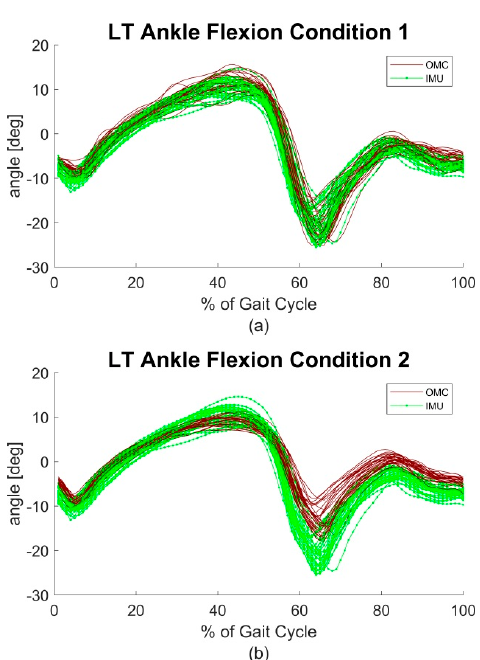
Figure 2. Left (LT) ankle flexion of a representative subject. Soft tissue artefacts (STA) error excluded ( a ) and included ( b ). At 60 to 100% Gait Cycle (GC) appears a typical offset between optical motion capture (OMC) and inertial measurement unit (IMU)-derived data.